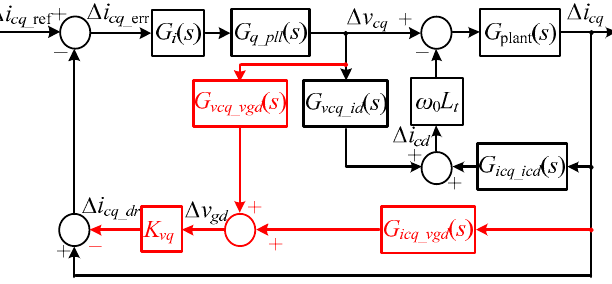
Figure 5. Control in the q -axis with voltage droop.